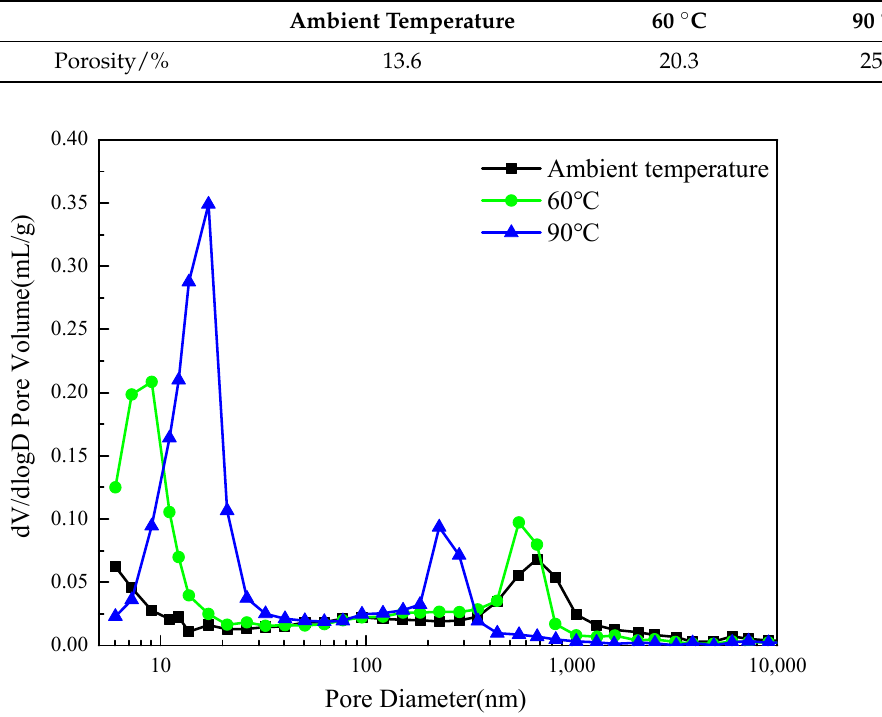
Figure 8. SEM images of HMGC under different curing temperatures at 7 d. Table 5. Porosity of HMGC under different curing temperatures.